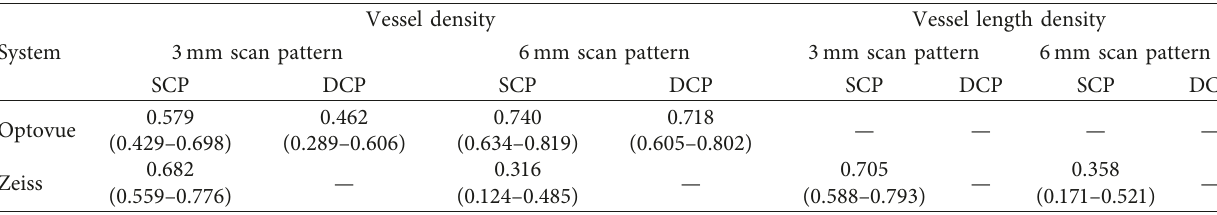
Table 1: Intraclass correlation coefficients (95% confidence interval) of the vessel density and vessel length density measurements derived with the built-in software of the Optovue and Zeiss systems.